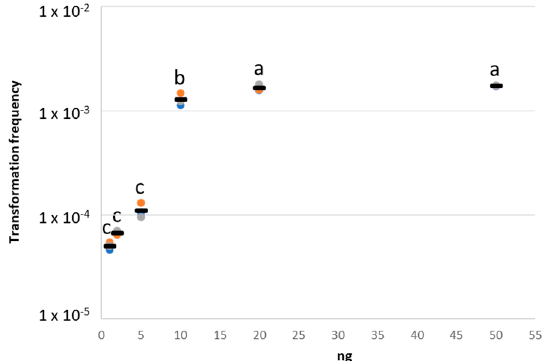
Figure 2. Selection of extracellular DNA quantities for in vivo A. baylyi BD413 natural transformation assays. Transformation frequency of A. baylyi BD413 was calculated by performing an in vitro natural transformation experiment on nitrocellulose membrane filters using a range of quantities of plasmid pZR80(gfp), chosen according to the literature information about exDNA concentration in wastewaters. The black line indicates the average value of three technical replicates. Different letters (a, b, c) indicate significant differences between the values of transformation frequency measured using DNA quantities ranging from 1 to 50 ng, according to the Tukey-Kramer post-hoc test (ANOVA, p -value < 0.0001).